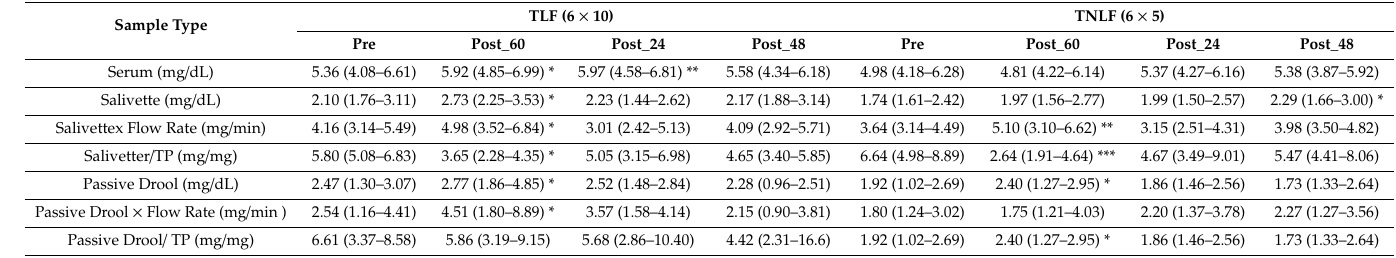
Table 1. Mean (interquartile range) data of serum and salivary uric acid (UA) before (Pre) and after 60 min (Post_60), 24 h (Post_24), and 48 h (Post_48) of acute exercise. TLF: training leading to failure, TNLF: training not leading to failure, TP: total